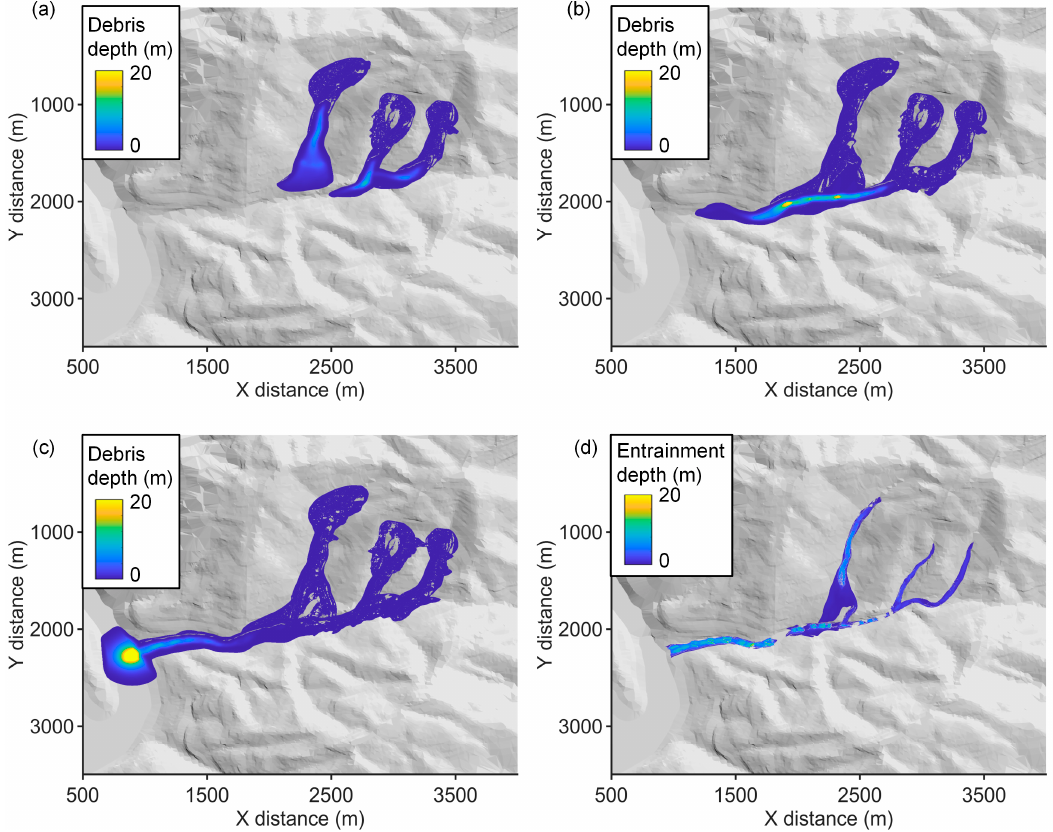
Figure 10. Simulation results of the 2010 Hongchun debris-flow process. ( a ) Time = 50 s. ( b ) Time = 100 s. ( c ) Time = 200 s . ( d ) The fi nal erosion depth contour.